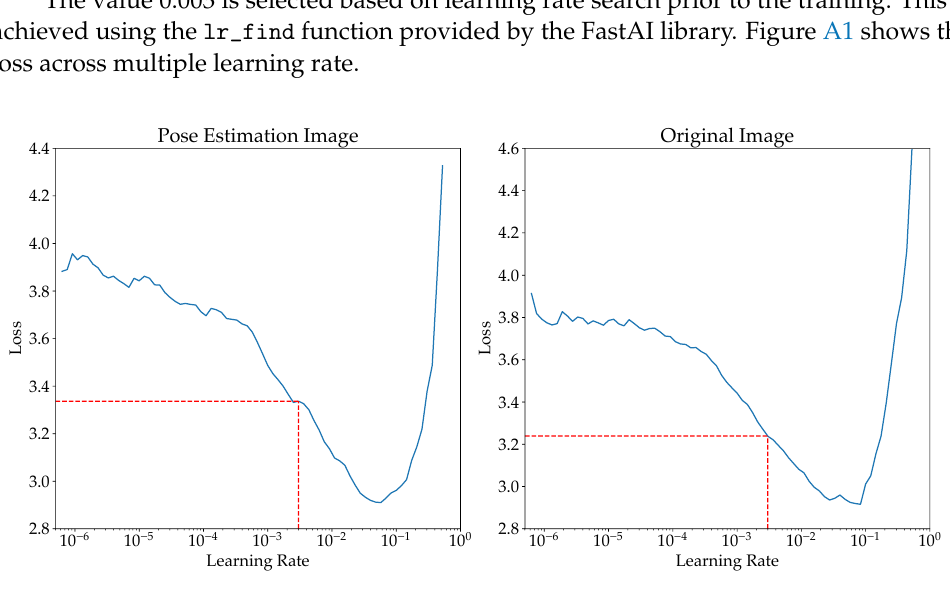
Figure A1. The learning rate search for both